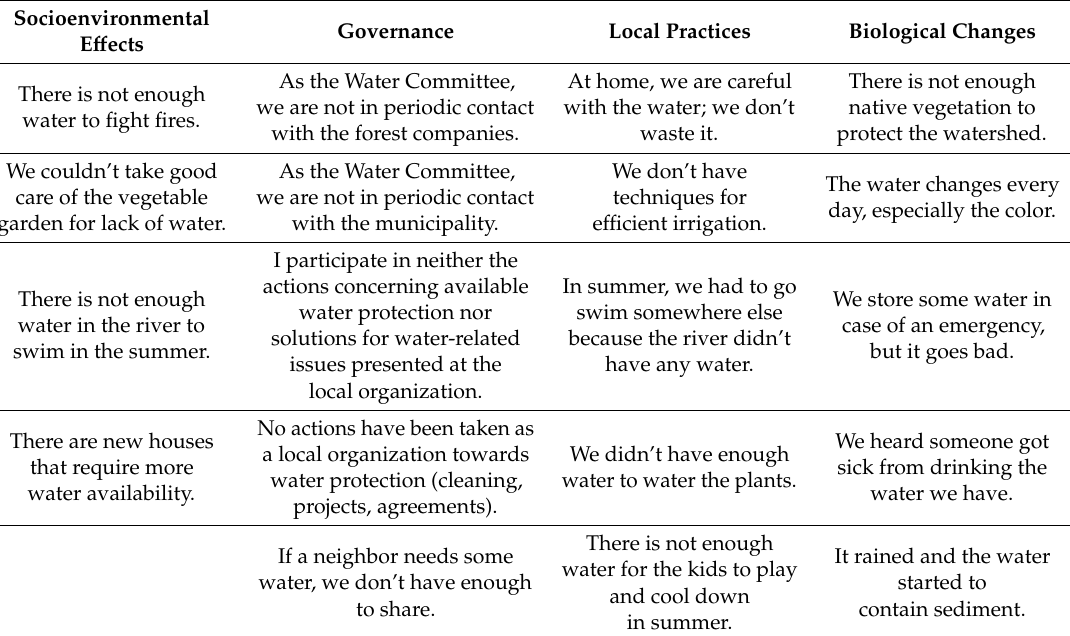
Table 1. Local indicators regarding the water situation in the